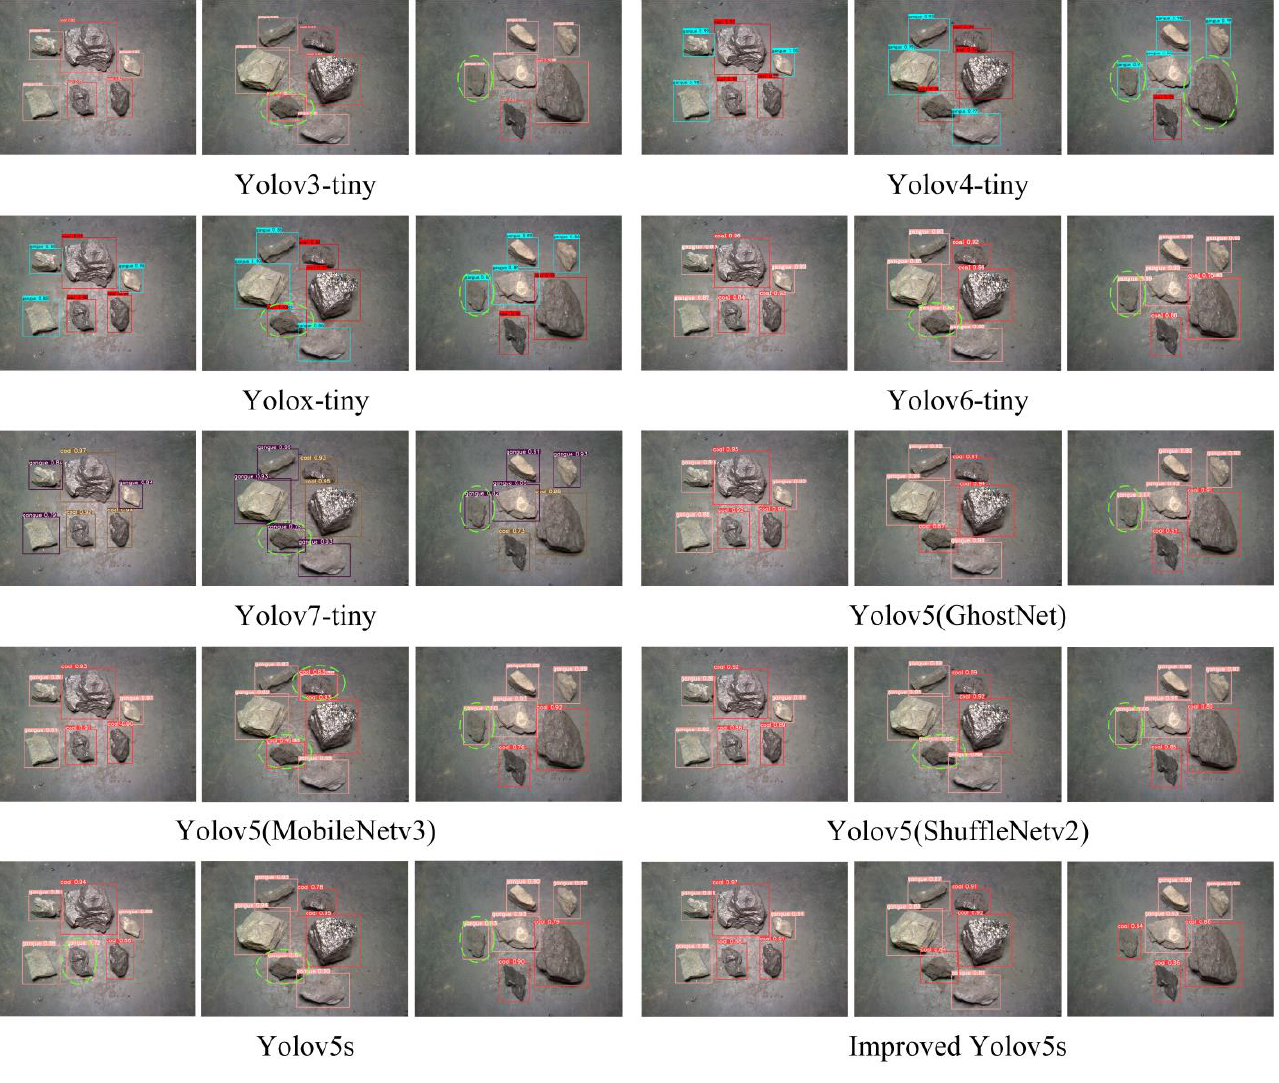
Figure 11. Comparison of detection results for coal and gangue.